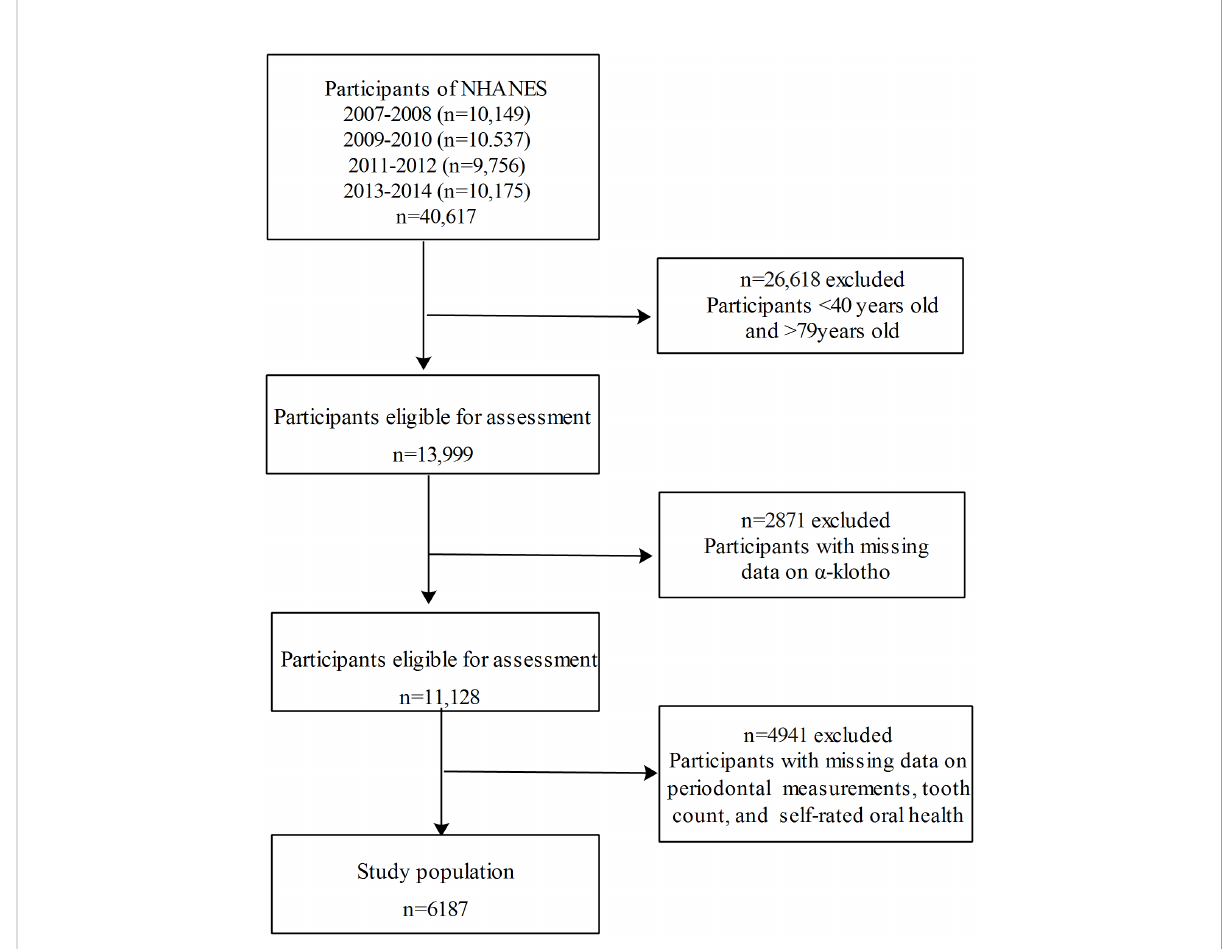
FIGURE 1 The inclusion and exclusion fl owchart of the study